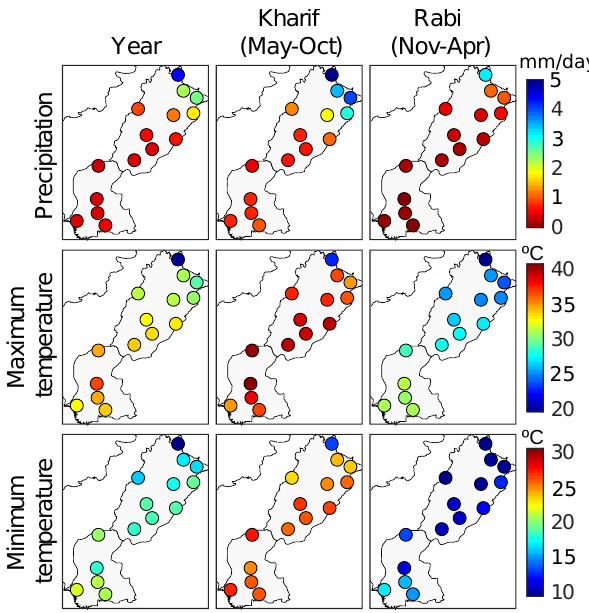
Figure 2. Observed mean climatology for precipitation, maximum and minimum temperature (in rows) for the 15 PMD stations over the period 1997–2016, for the entire year and the Kharif and Rabi seasons (in